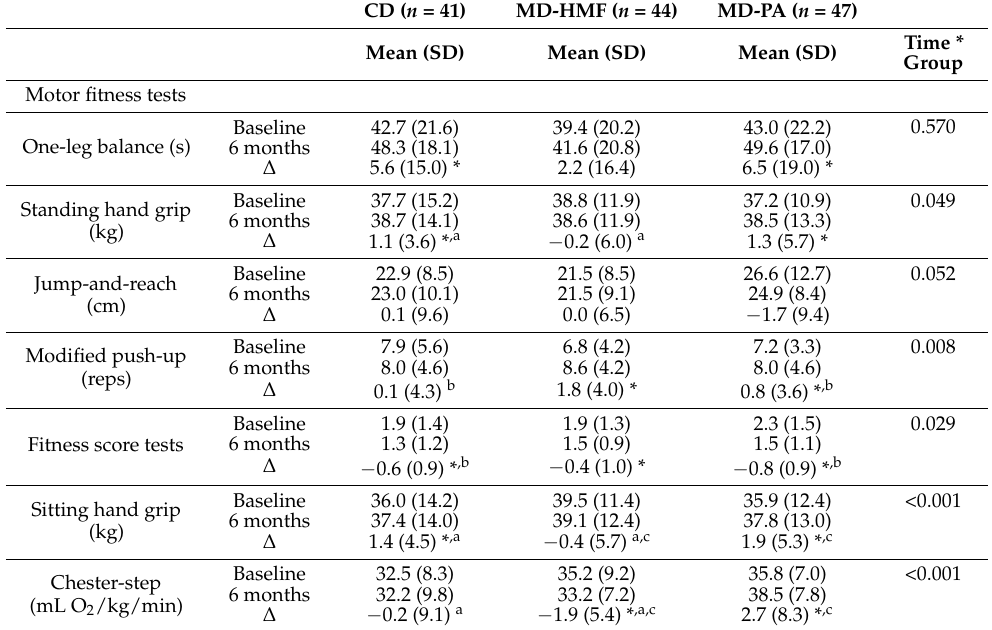
Table 2. Changes in physical activity tests within, and between, intervention groups at 6 months versus